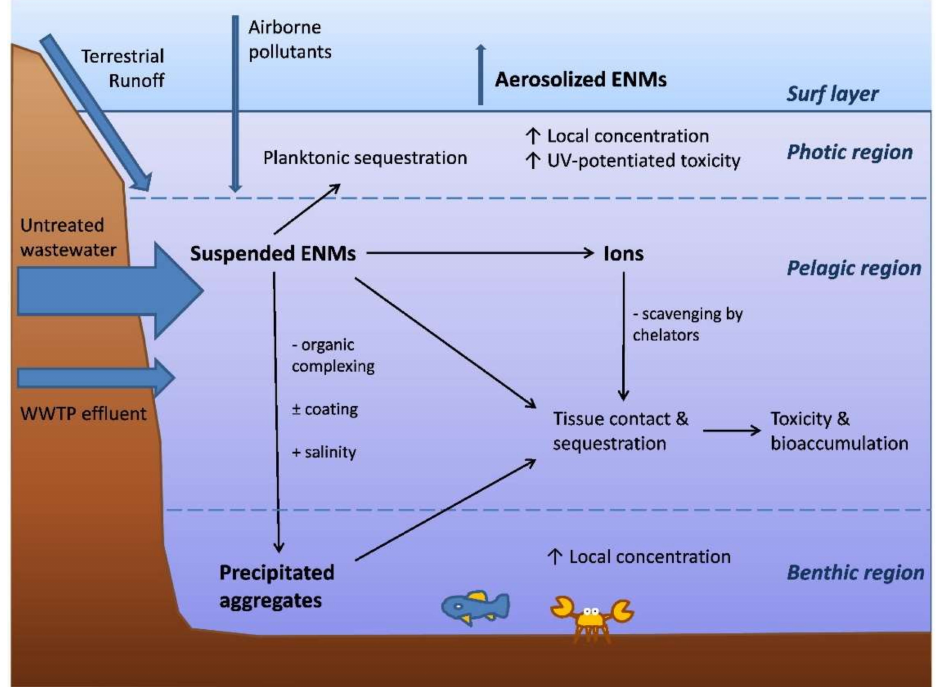
Figure 2. Destiny of engineered nanometals ENMs in an estuary environment. The relative abundance is indicated by the thickness of the arrows. Image used with the permission of Elsevier